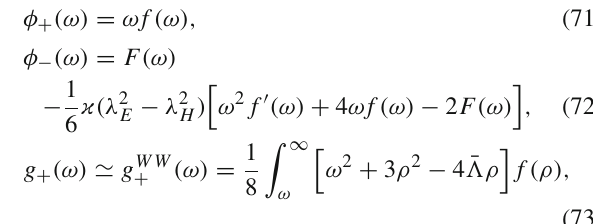
(cid:22) ( 1 , q 2 )/ m q 2 F ( l = 0 ) 0 + f (cid:4)(cid:4) 0 0